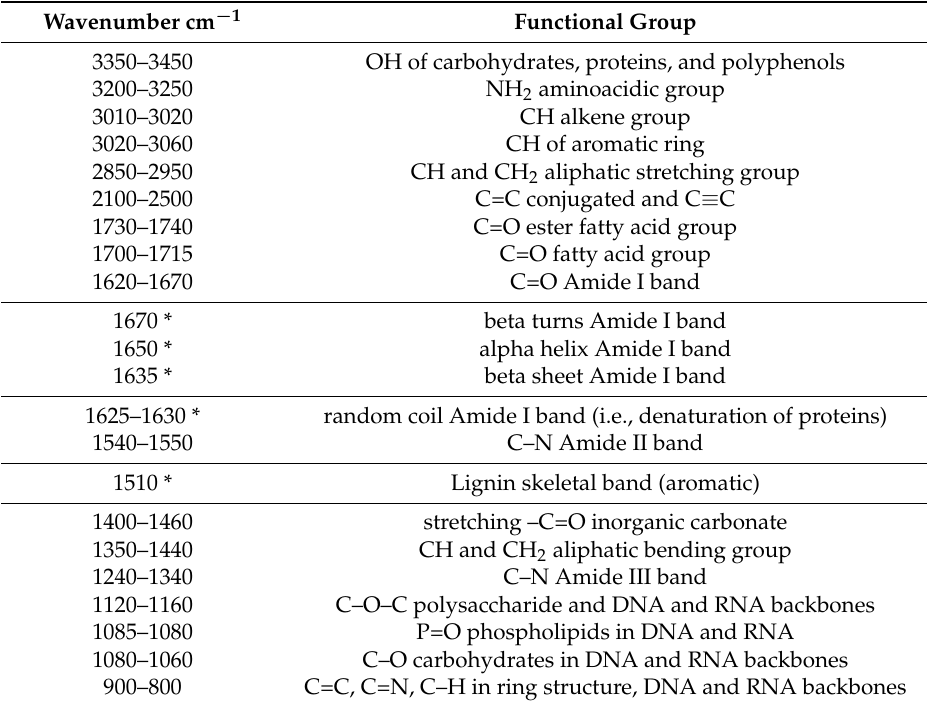
Table 1. List of the most significant infrared (FTIR) bands and related functional groups assigned for Vicia faba samples. The “*" bands are evidenced by means of second derivative spectroscopy.